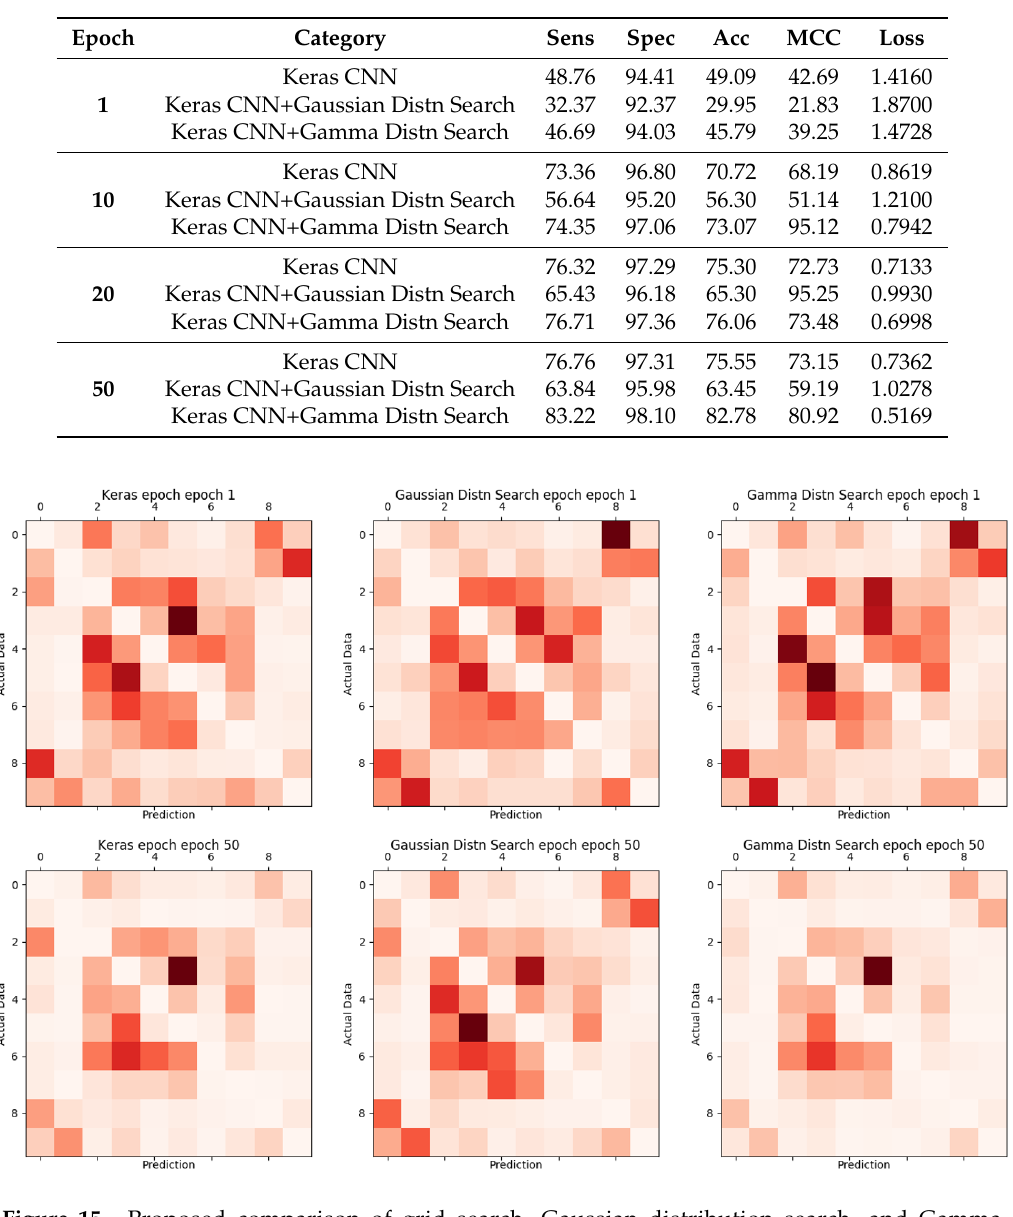
Table 5. Comparison of keras CNN, Gaussian distribution search of keras CNN, and Gamma